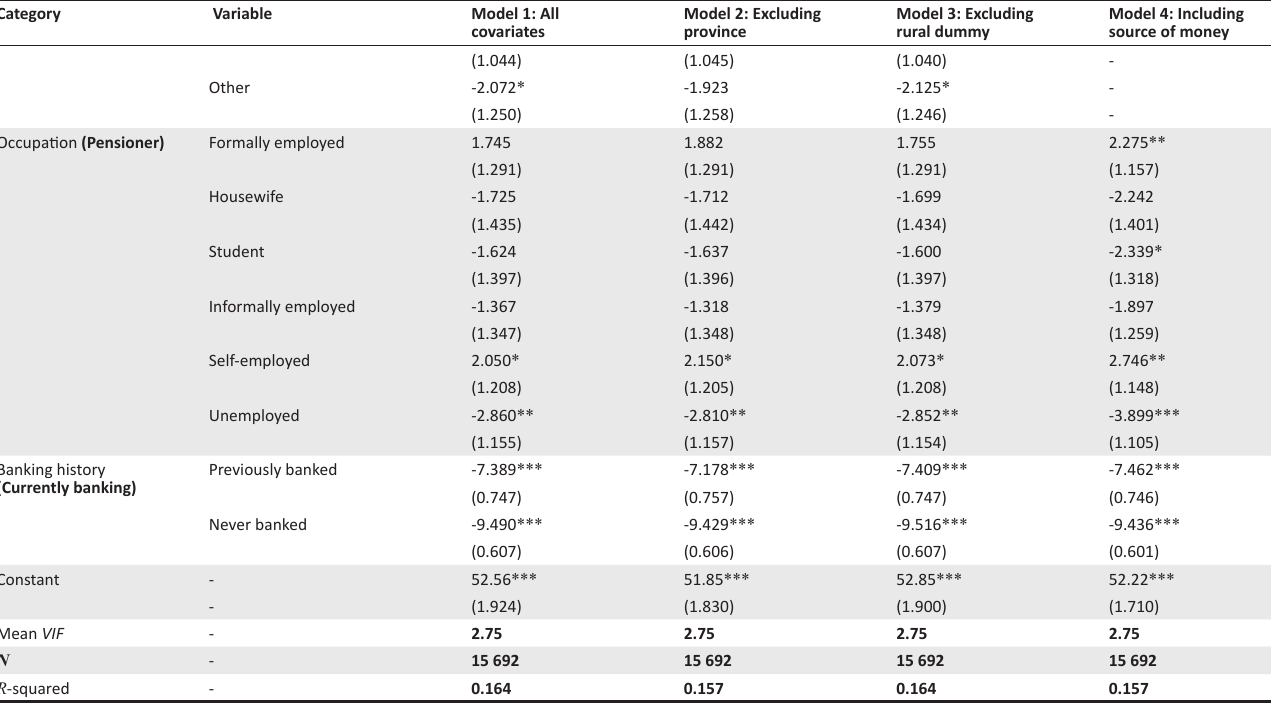
TABLE 4 (Continues...): Multivariate correlates of financial literacy in South Africa. Category